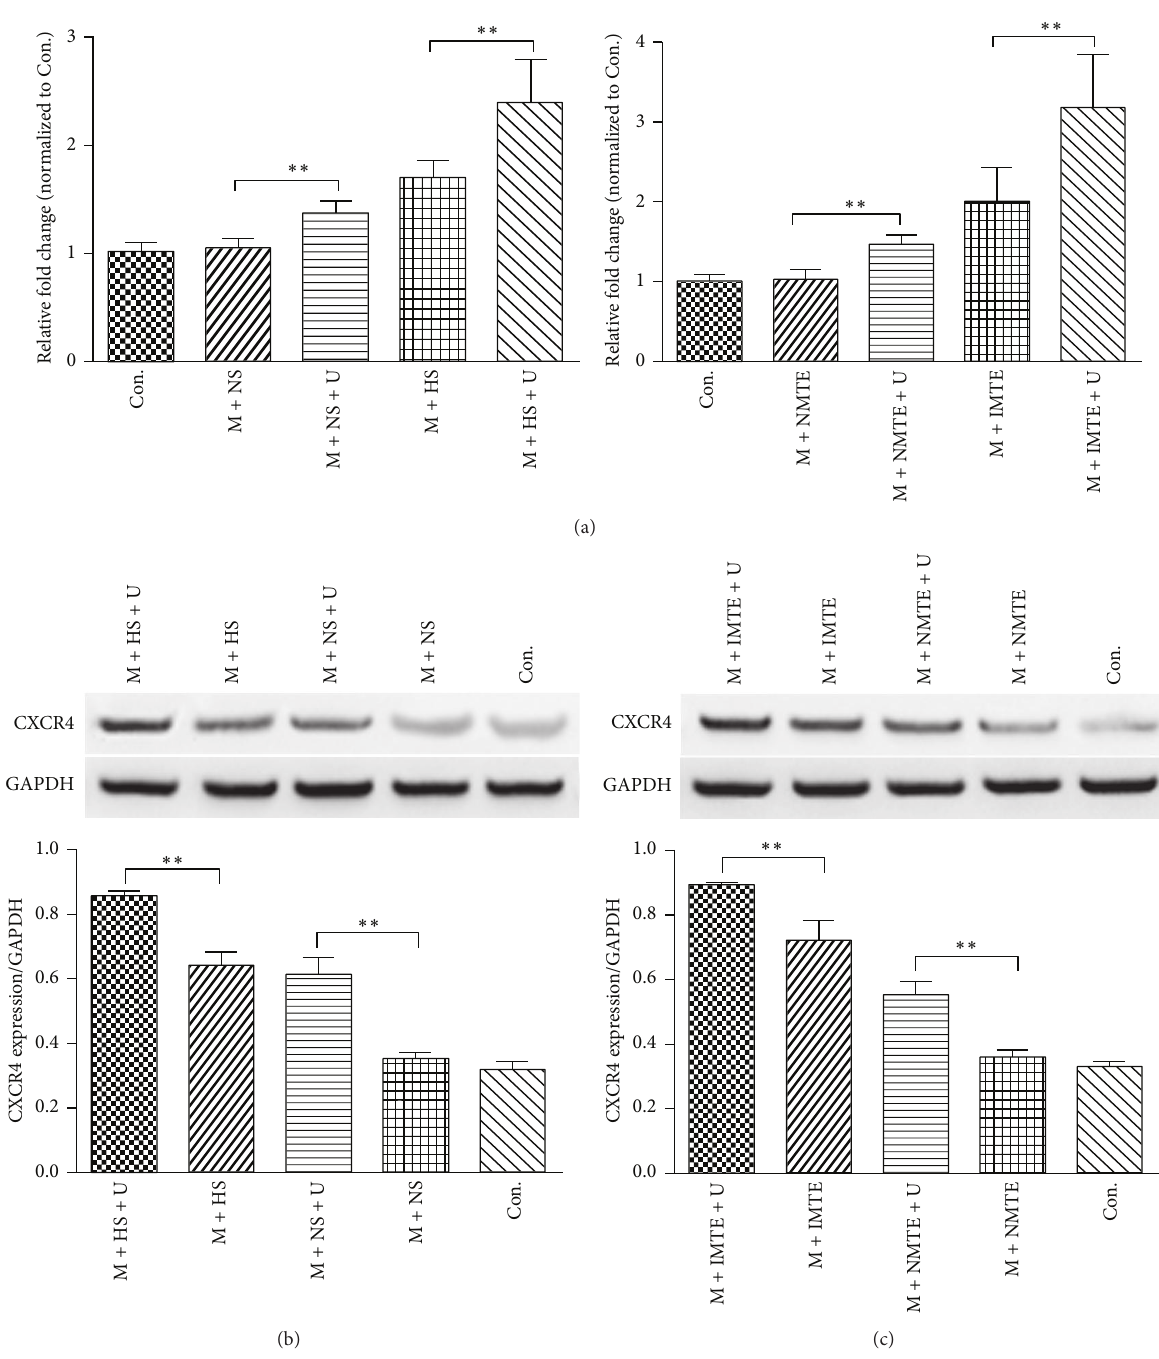
Figure 3: CXCR4 mRNA and protein expression in vitro. (a) Real-time PCR analysis of CXCR4 mRNA expression in MSCs from the different supernatant and MTE groups. The relative expression level was normalized against the control group, with GAPDH as an internal standard. ((b) and (c)) Western blot analysis for CXCR4 protein expression within MSCs from the different supernatant or MTE groups, respectively. The results from each group were normalized to GAPDH expression. All values are expressed as the mean ± SD. ∗∗ 𝑃 < 0.01 ; 𝑛 = 6 .